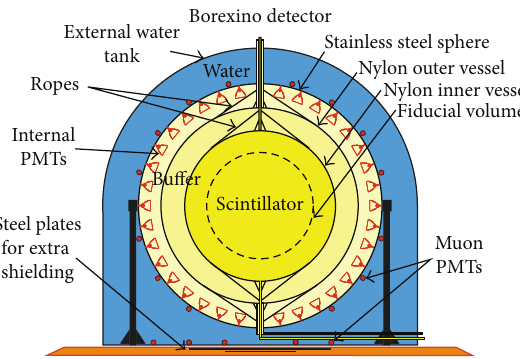
Figure 4: Schematic diagram of the Borexino